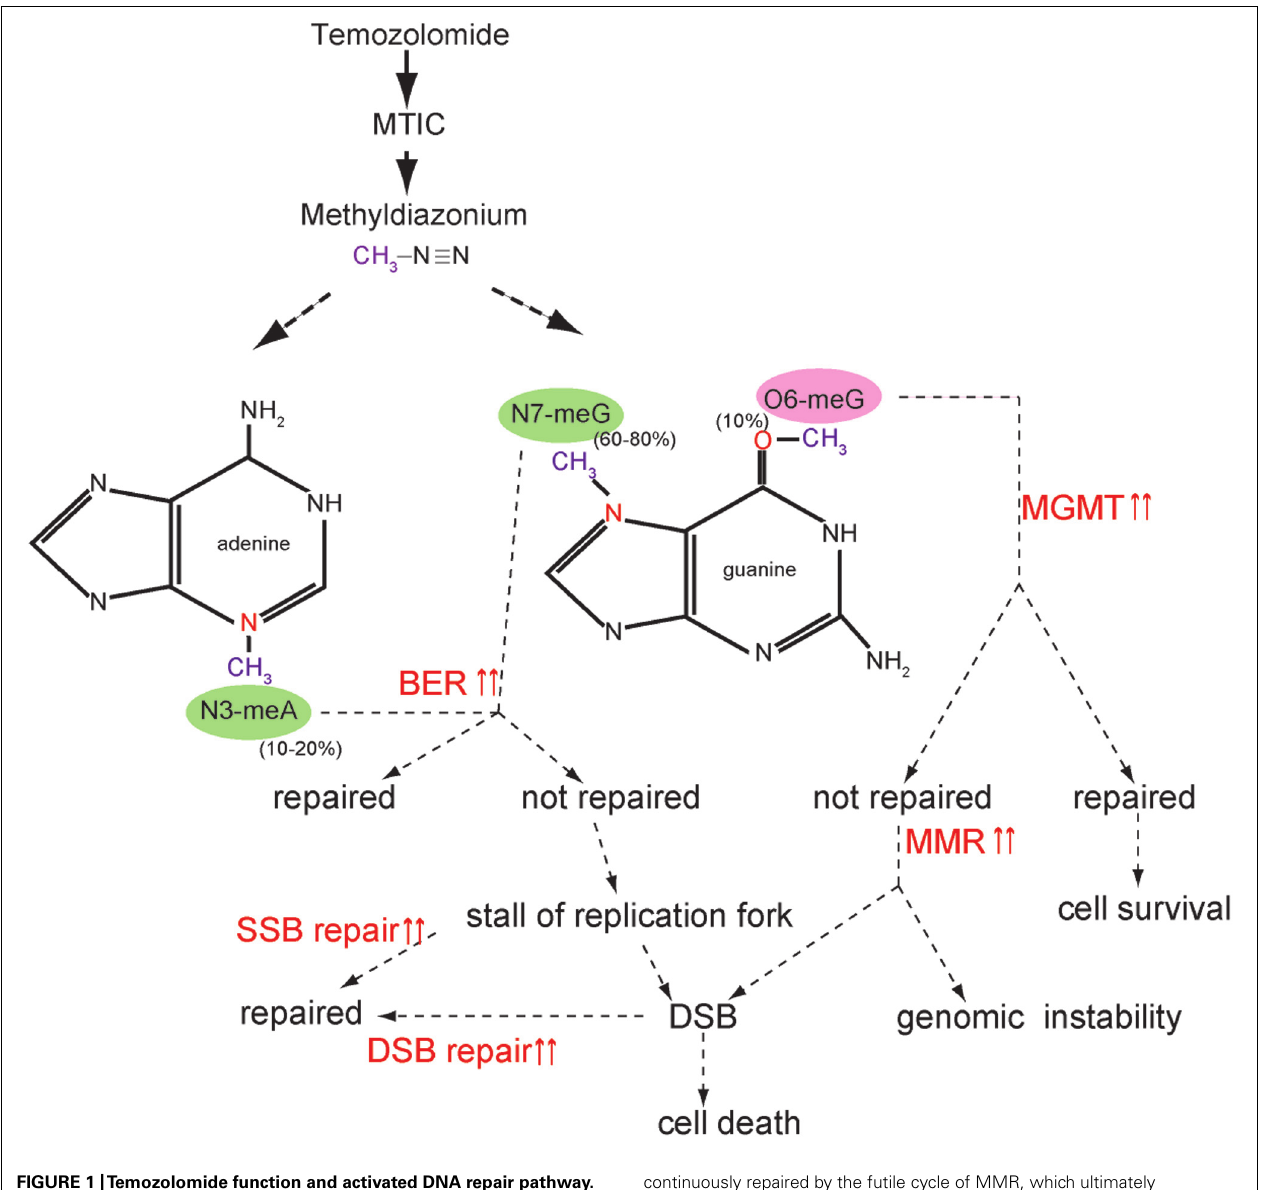
FIGURE 1 |Temozolomide function and activated DNA repair pathway. Temozolomide (TMZ) is chemically converted to MTIC (5-3-(methyltriazen-1-yl) imidazole-4-carboximide) at physiologic pH and degrades to a methyldiazonium cation, which transfers a methyl group to DNA.The most common site of methylation is N7-MeG (60–80%) followed by N3-MeA (10–20%) and O6-MeG (5–10%).When active MGMT is present, O6-MeG is repaired without cytotoxicity.When MGMT is inactivated or does not have the potential to completely repair O6-MeG, unrepaired O6-MeG is